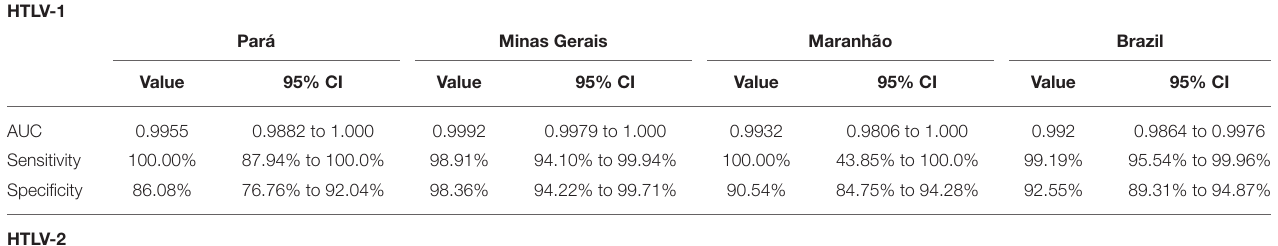
TABLE 3 | Statistical analysis of the ELISA multi-epitope recombinant’s performance by state and HTLV-1 and HTLV-2 samples.